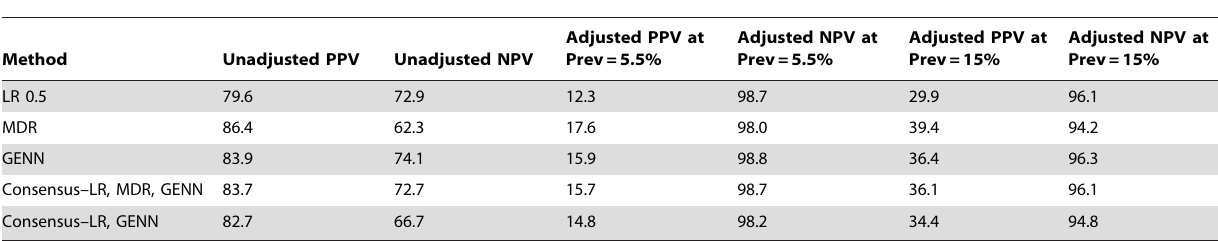
Table 5. Comparison of adjusted and unadjusted PPV and NPV in the VM testing dataset.